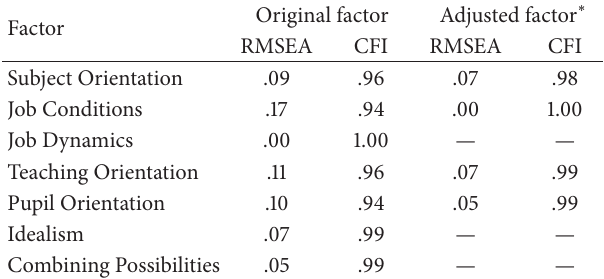
Table 3: RMSEA and CFI for each factor separately. Table 4: Descriptive statistics (mean and standard deviation) for